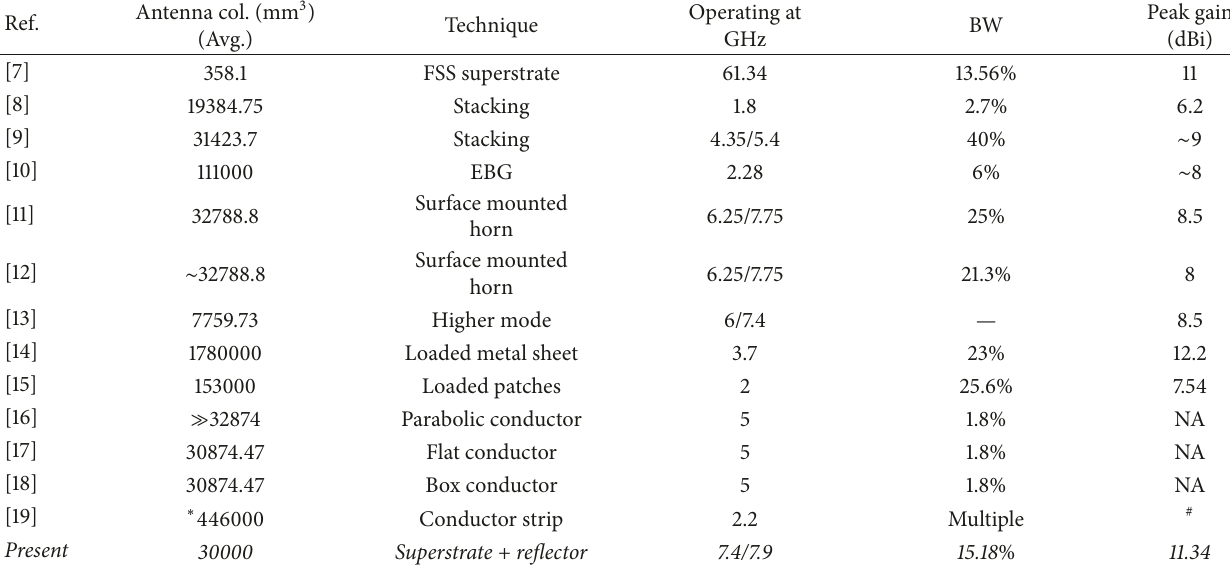
Table 3: Comparison of proposed work with available literature.